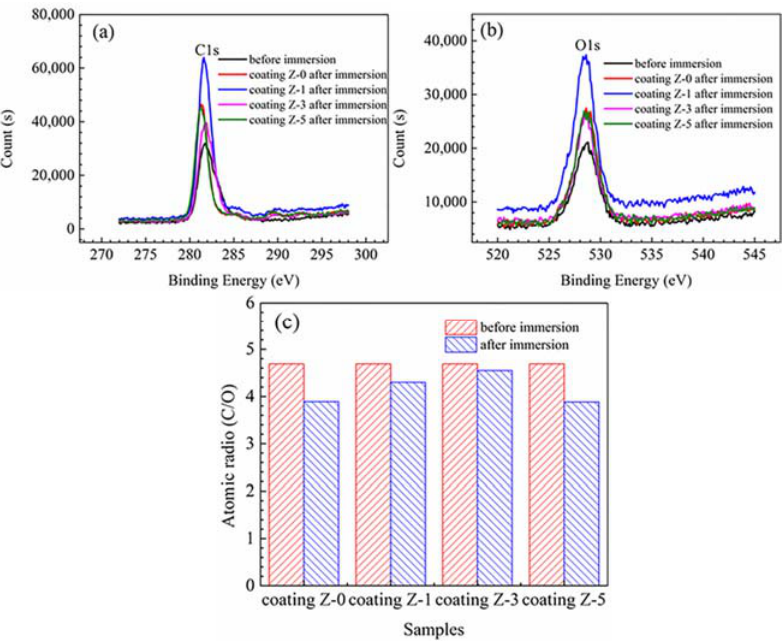
Figure 6. XPS spectra (C1s ( a ), O1s ( b )) and atomic radio (C/O) ( c ) of the Z-0, Z-1, Z-3, and Z-5 coatings before and after acid immersion.